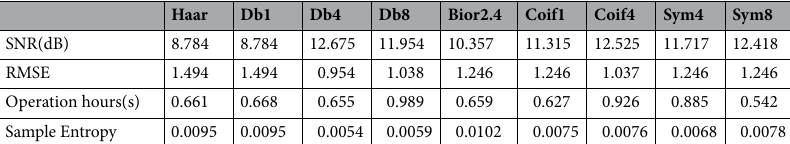
Table 2. Quantitative evaluation of the denoising effect of different wavelet basis